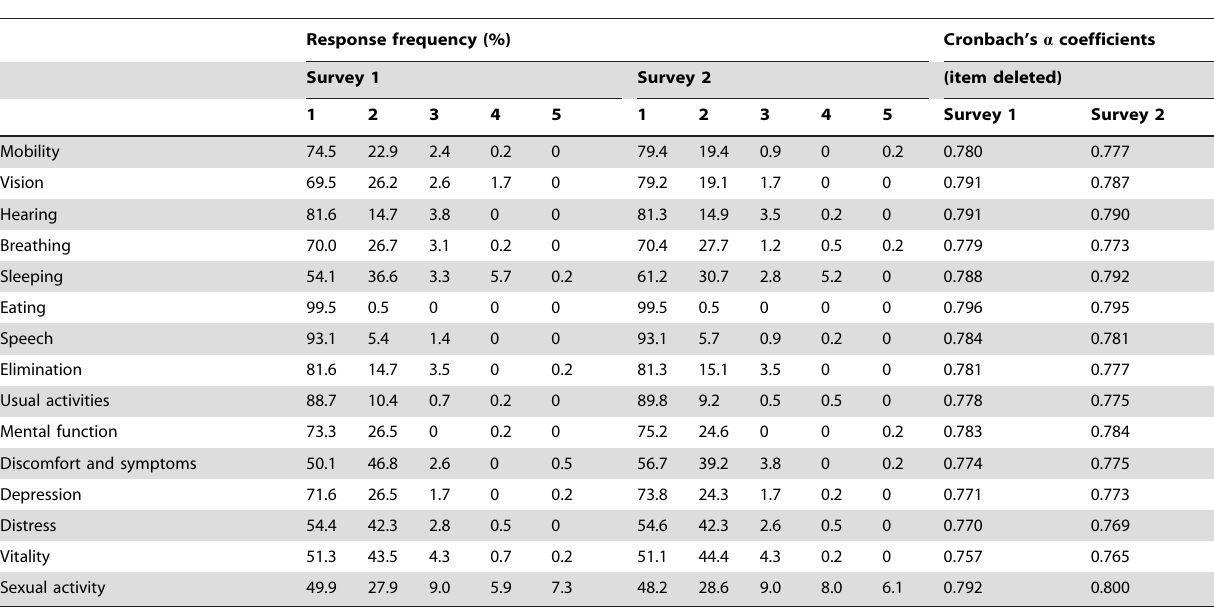
Table 2. Descriptive statistics and internal consistency of items on the